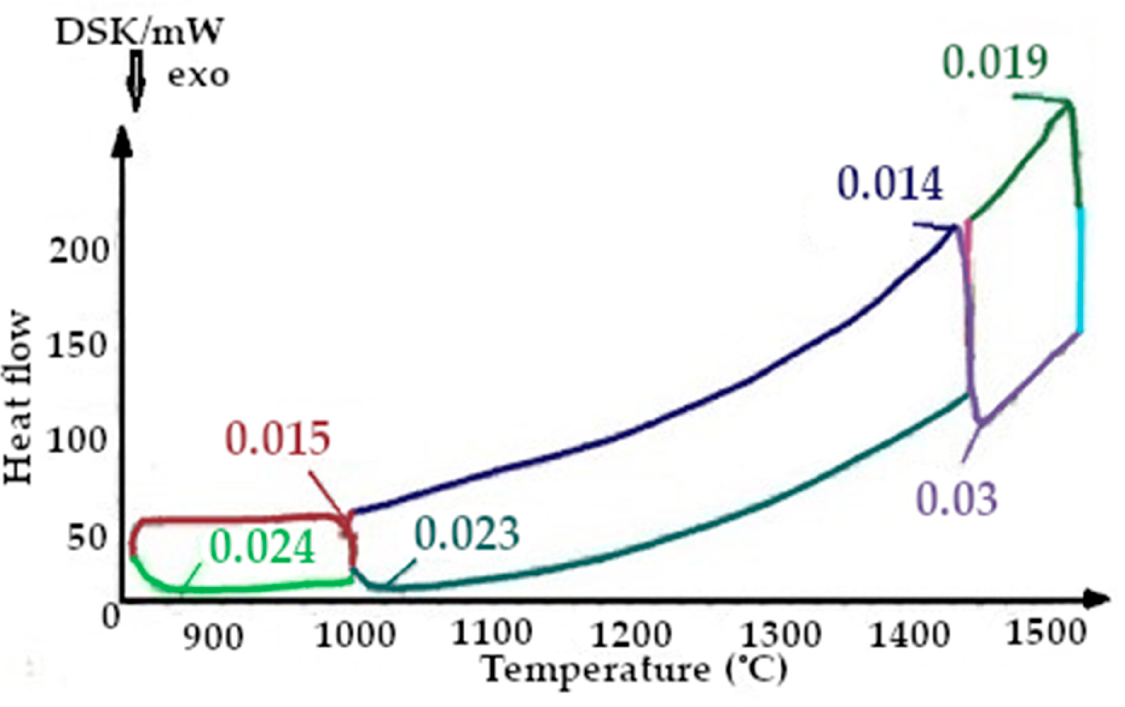
Figure 9. Fragment of the thermogram of quartzite, calcified at 200 ◦ C (Cycle 1), where: